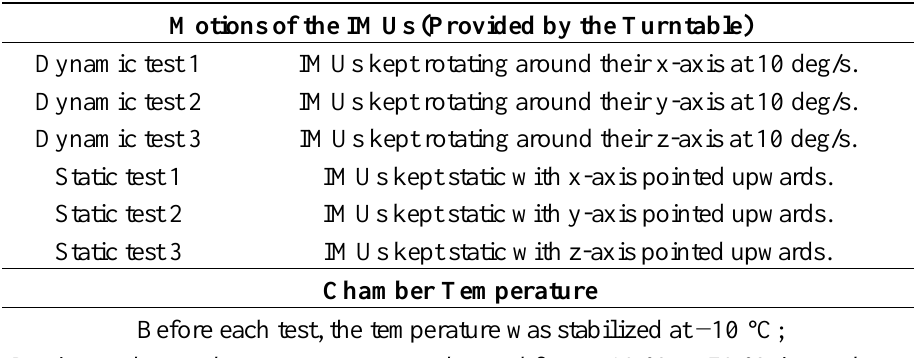
Table 8. Descriptions of the six thermal compensation tests.